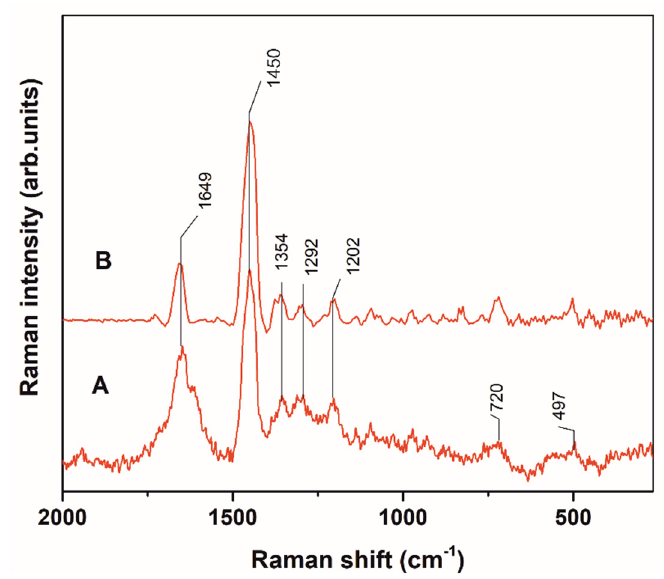
Figure 5. Comparison of Raman spectra of resin from Khatanga (Russia) collected with laboratory (A) and handheld (B) equipment.